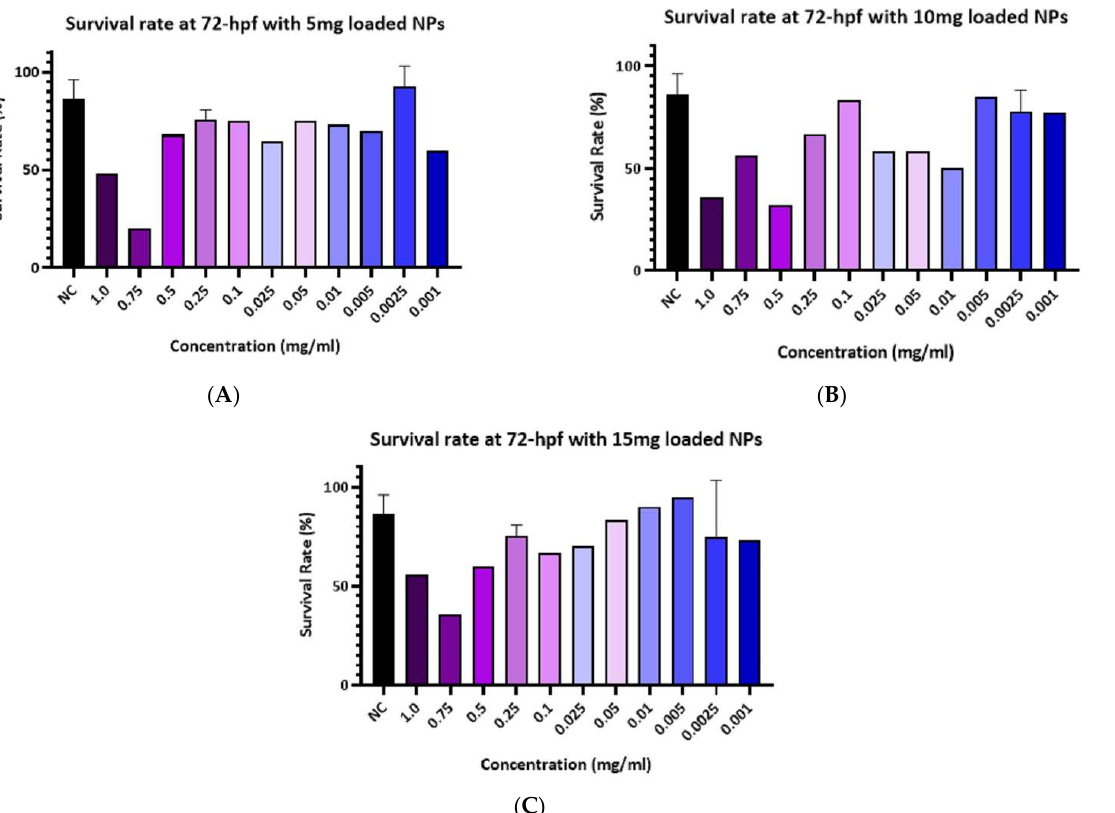
Figure 5. The survival rate of embryos exposed to different concentrations of Ponatinib-loaded PLGA-PEG-PLGA NPs. ( A ) The survival rate of embryos exposed to Ponatinib (5 mg) PLGA-PEG-PLGA NPs compared to the NC, at 72 hpf, higher concentrations of the loaded PLGA-PEG-PLGA NPs (1 and 0.75 mg/mL) had the lowest survival rate compared to the other groups. ( B ) The survival rate of embryos exposed to Ponatinib (10 mg) PLGA-PEG-PLGA NPs compared to the NC, at 72 hpf, groups that were treated with loaded PLGA-PEG-PLGA NPs (1 and 0.5 mg/mL) showed the lowest survival rate. ( C ) The survival rate of embryos exposed to different concentrations of Ponatinib (15 mg) loaded PLGA-PEG-PLGA NPs compared to the NC, at 72 hpf. The treated groups with loaded PLGA-PEG-PLGA NPs (1 and 0.75 mg/mL) showed the lowest survival rate when compared to the other